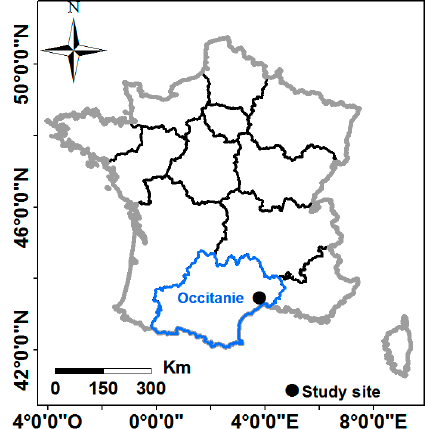
Figure 1. Location of the study site.